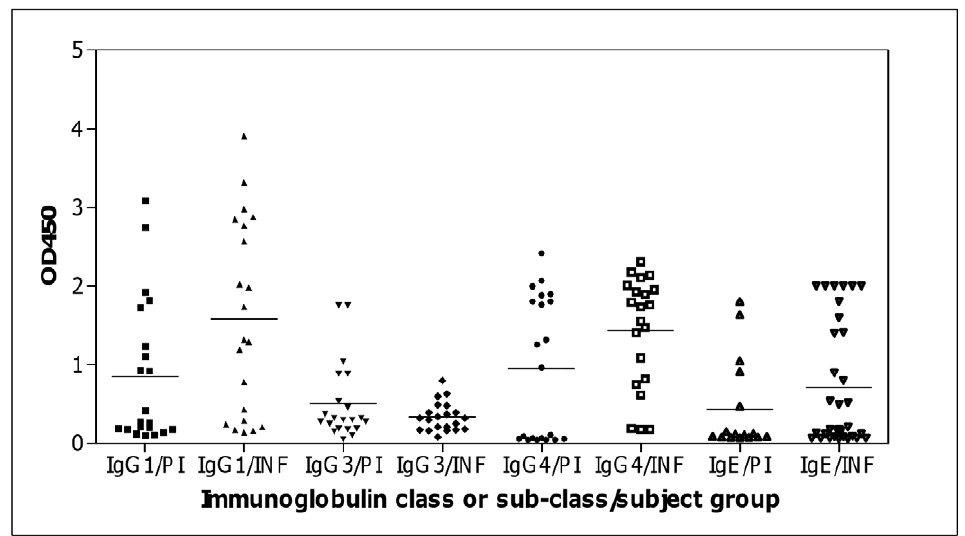
Figure 2. Human IgG sub-classes and IgE class antibody responses to recombinant Ov -CPI-2 in the PI and the INF. The median IgG1, IgG3, IgG4 and IgE responses to r Ov -CPI-2 in the PI (N=21) and INF subjects (N=21) are indicated with short, solid horizontal lines. The median IgG1 and IgG4 responses are significantly higher in the INF ( P =0.03 and 0.04 respectively) than in the PI.